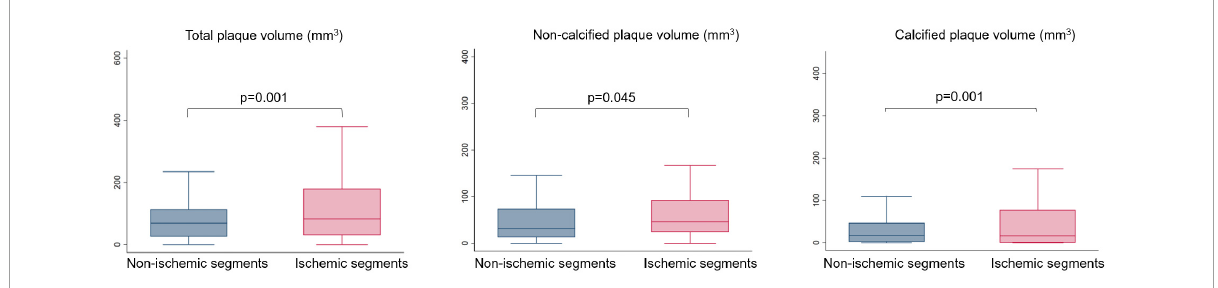
FIGURE3 Box plots showing the distribution of total, non-calcified and calcified plaque volumes related to ischemic and non-ischemic myocardial segments based on DPCT (MBF < 101 ml/100 g/min vs. ≥ 101 ml/100 g/min). DPCT, Dynamic perfusion CT; MBF, Myocardial blood